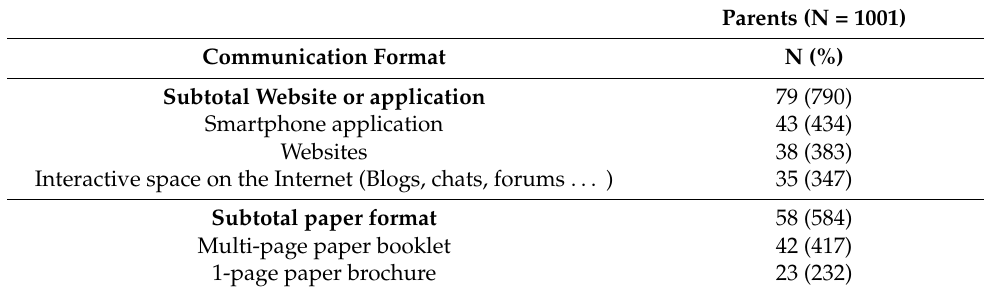
Table 2. The appropriate means to receive CoF information according to parents (N =